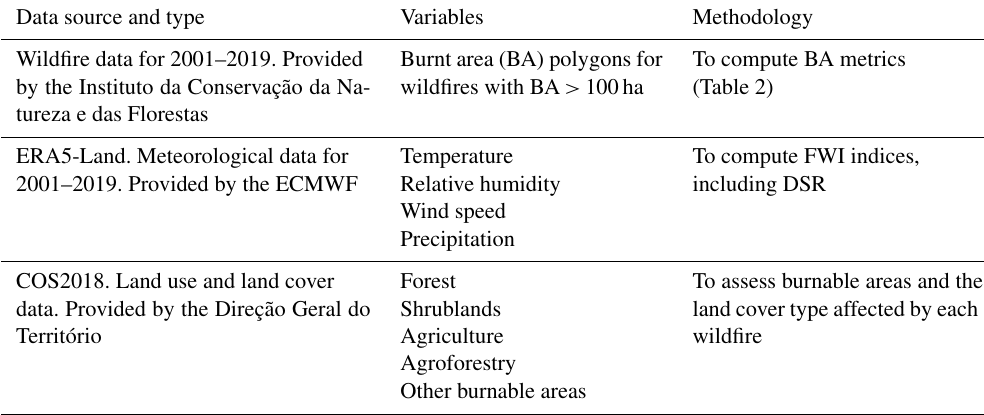
Table 1. Data sources and types, variables and methodology where it is used. Data source and type Wildfire data for 2001–2019. Provided